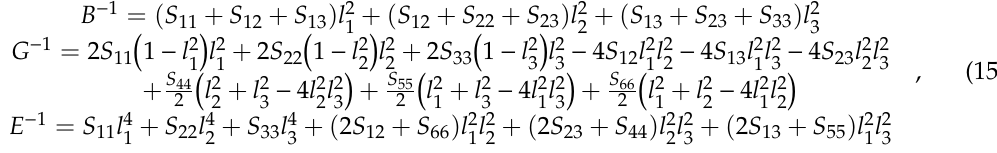
Figure 9. Relationship between bulk modulus and pressure along the a and c axes under uniaxial compression.